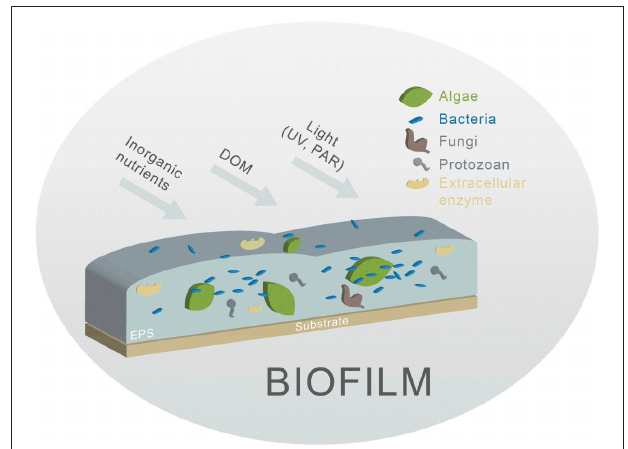
FIGURE 2 | An idealized scheme of the biofilm components in streams. The different biofilm components (algae and bacteria, as the principals) are embebbed in a expolisaccharide matrix (EPS), and are net receptors of inorganic and organic elements and remain submitted to the influences of the different environmental